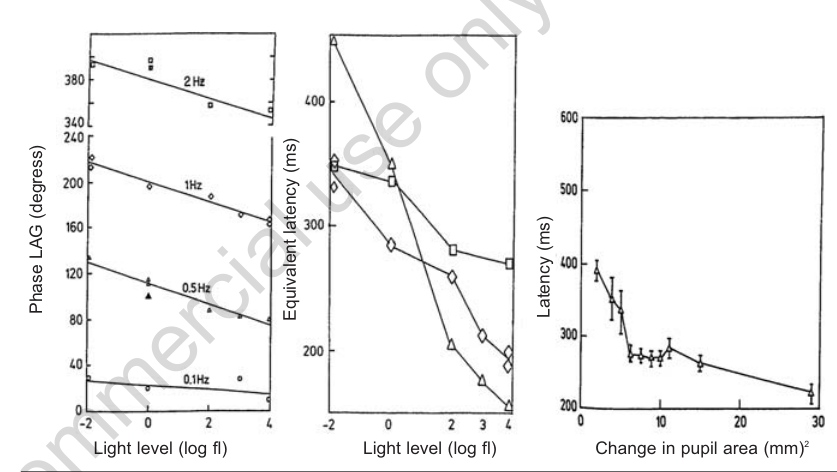
class.Figure 4. Single case example of a 59-year old male diabetic patient with autonomous polyneuropathy, who had suffered from a left dorso-paramedian ponto-mesencephalic lacu- nar stroke. (A) cMRT. (B) Values of his most important pupil recording